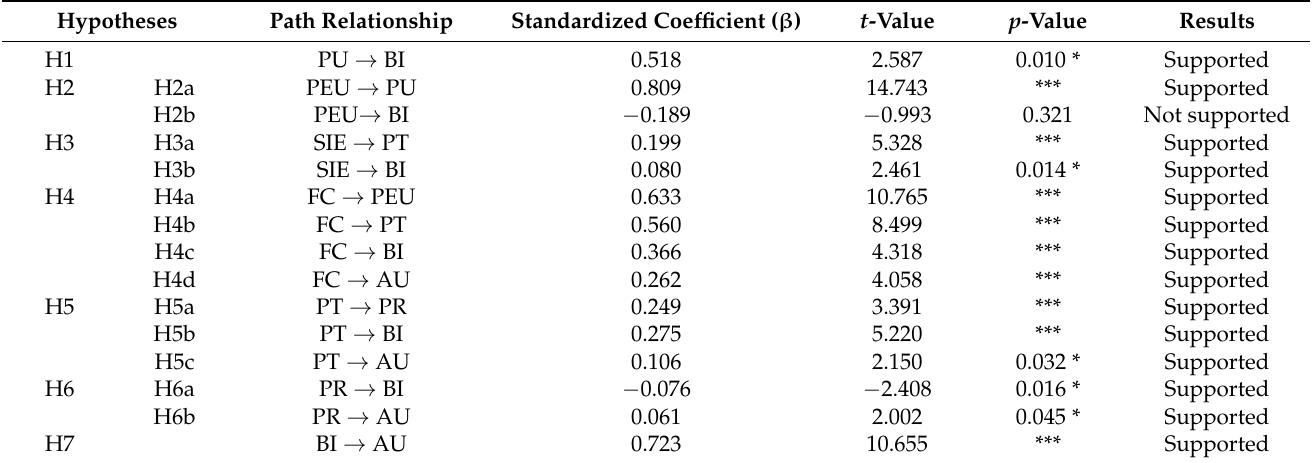
Table 1. Path analysis results. Denotes that *— p < 0.05 and ***— p <